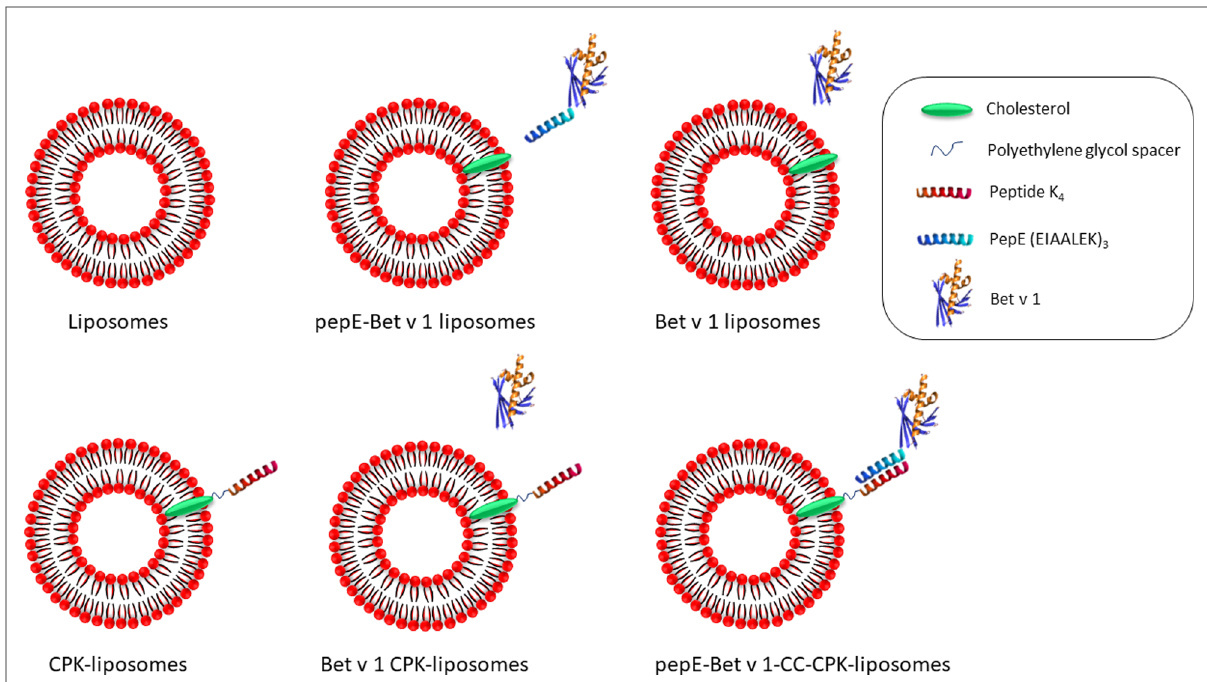
FIGURE 1 Schematic design of the liposomes used in this study. DSPC, DOTAP and cholesterol were mixed to generate liposomes (top left). The liposomes were functionalized with peptide K 4 attached to a cholesterol anchor in the lipid bilayer via a polyethylene glycol spacer (CPK-liposomes, bottom left). PepE fused to the N-terminus of Bet v 1 enabled coiled coil mediated attachment to the CPK-liposomes (pepE-Bet v 1-CC-CPK-liposomes, bottom right). As control groups, pepE-Bet v 1 was added to liposomes (pepE-Bet v 1 liposomes, top middle), Bet v 1 was added to liposomes (Bet v 1 liposomes, top right) or Bet v 1 was added to CPK-liposomes (Bet v 1 CPK-liposomes, bottom